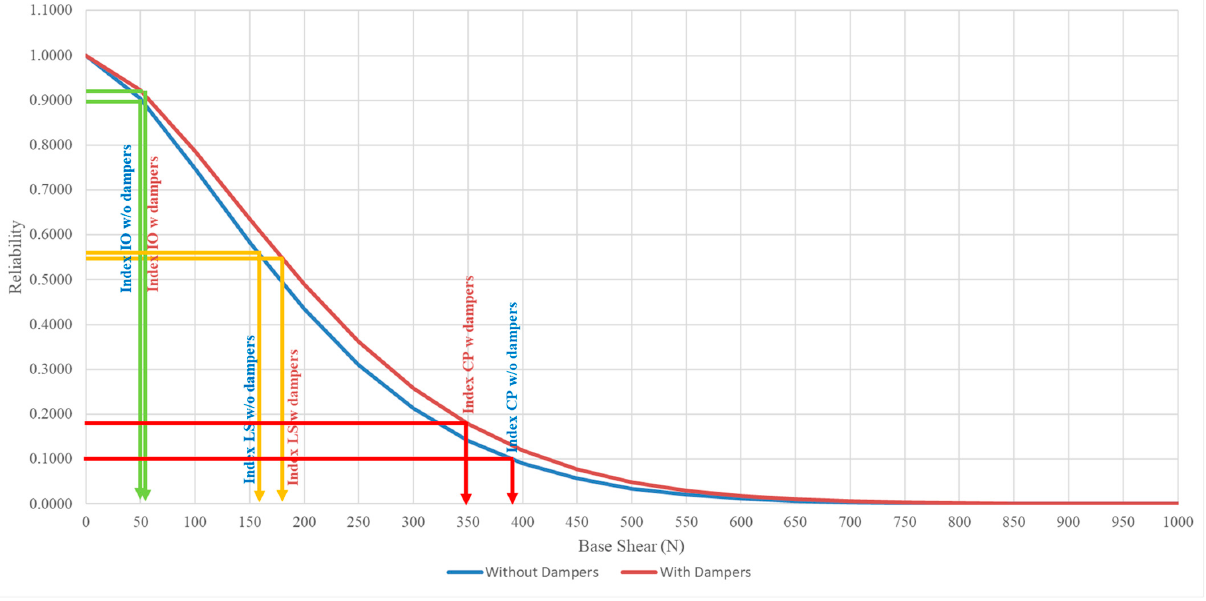
Figure 15. Reliability plot for structures with and without dampers attached to the roof storey.